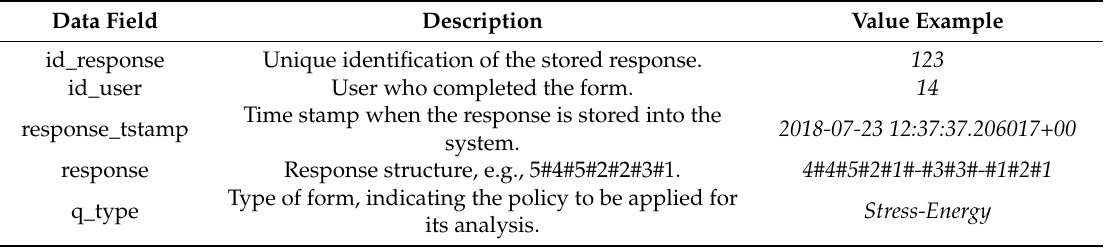
Table 3. Data Structure of a Questionnaire Response.